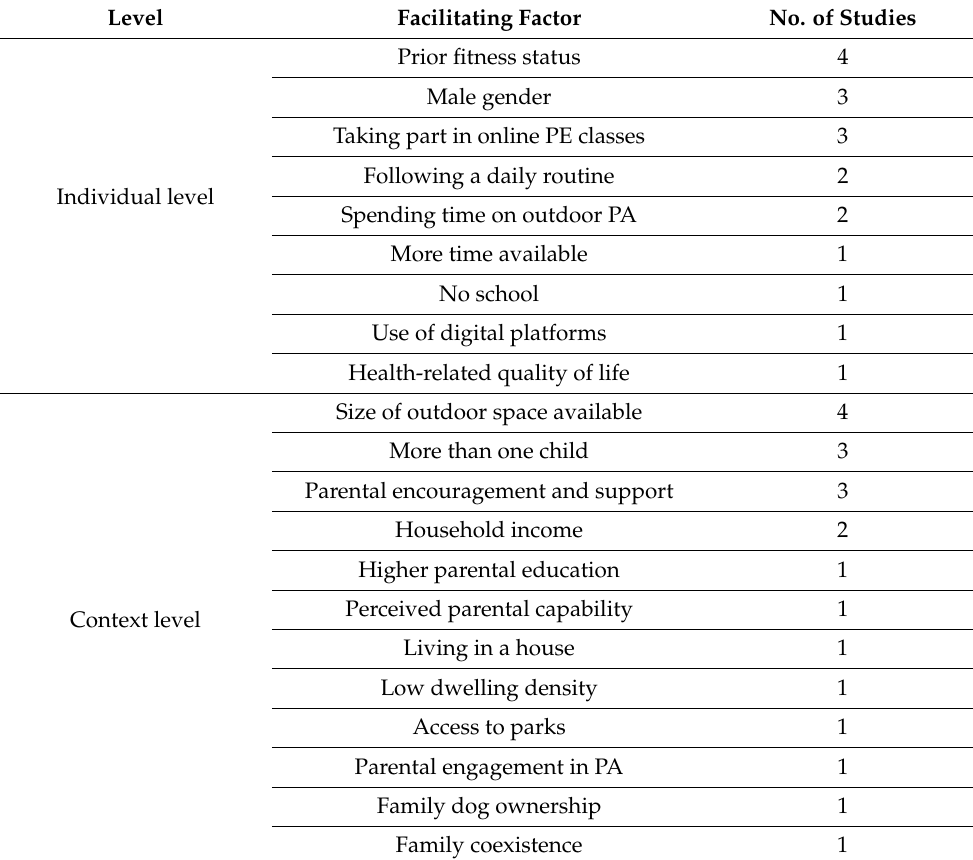
Table 2. Facilitating factors in children’s physical activity (PA) during the COVID-19